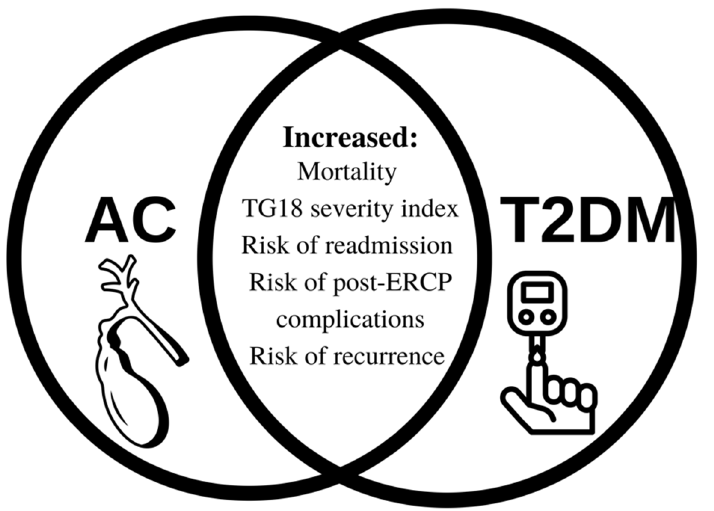
Figure 2. The main implications of type 2 diabetes mellitus in patients with acute cholangitis. Legend: AC, acute cholangitis. T2DM, type 2 diabetes mellitus. TG18, Tokyo Guidelines 2018. ERCP, endoscopic retrograde cholangiopancreatography.